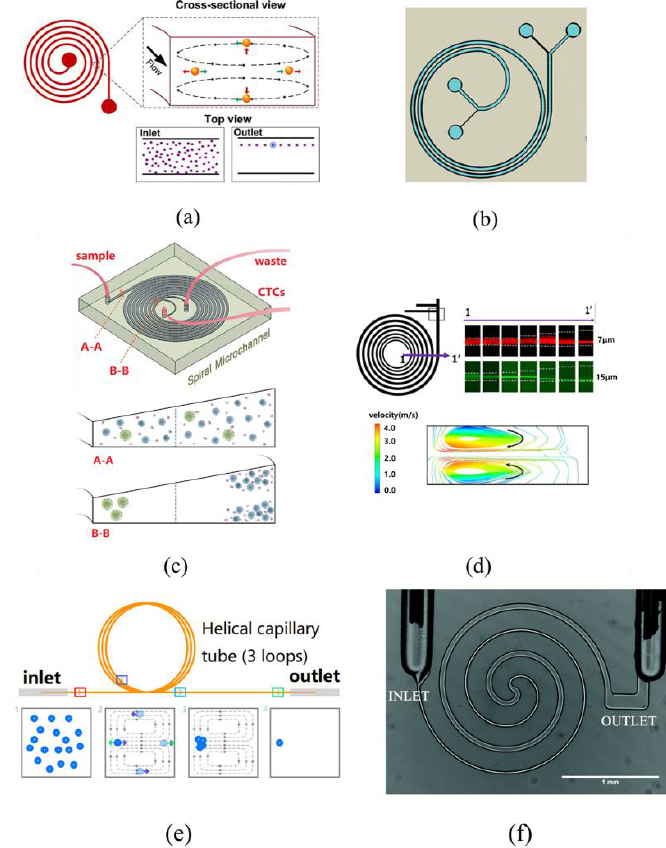
Figure 10. Applications of spiral-channel inertial microfluidics. ( a ) Sheathless flow cytometry system based on principle of Dean-coupled inertial microfluidics. Ref. [88]. Copyright (2009), with permission from Springer Nature; ( b ) Spiral system to realize enrichment of CTCs with recovery of 85% and 99.99% depletion of white blood cells in whole blood. Ref. [90]. Copyright (2015), with permission from Springer Nature; ( c ) Spiral microfluidic device with trapezoidal cross-section. Ref. [94]. Copyright (2017), with permission from Springer Nature; ( d ) Redesign of outlet channel as a series of side-branching channels perpendicular to main channel to separate 7-μm, 10-μm, and 15-μm fluorescent beads. Ref. [97]; ( e ) Three-dimensional spiral inertial focusing device using glass capillary tubes to realize separation of particles with 100% efficiency. Ref. [99]. Rights managed by AIP Publishing; ( f ) Method to isolate bacteria from whole blood rapidly based on principle of Dean flow. Ref. [102].